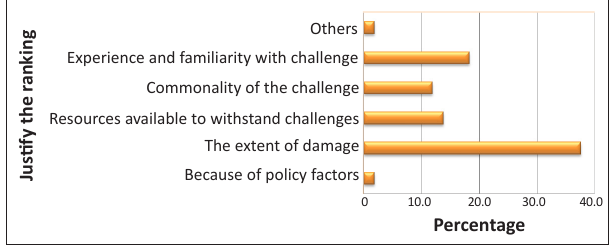
FIGURE 11: Support in times of disaster-induced hardships.